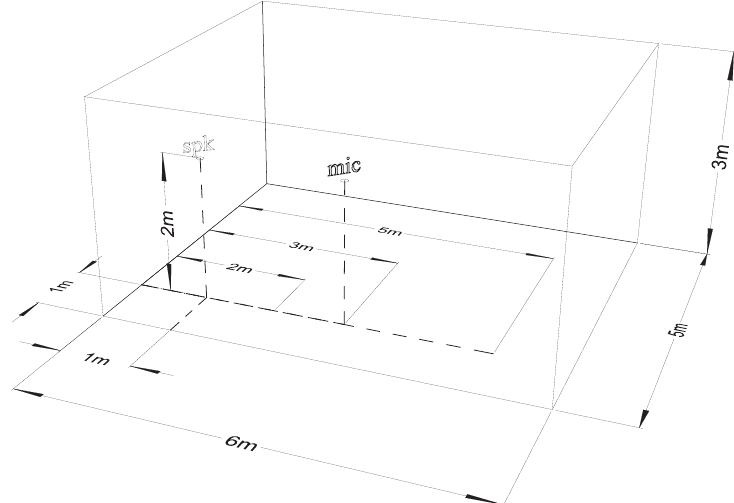
Figure A2. The room that is used to produce the experimental